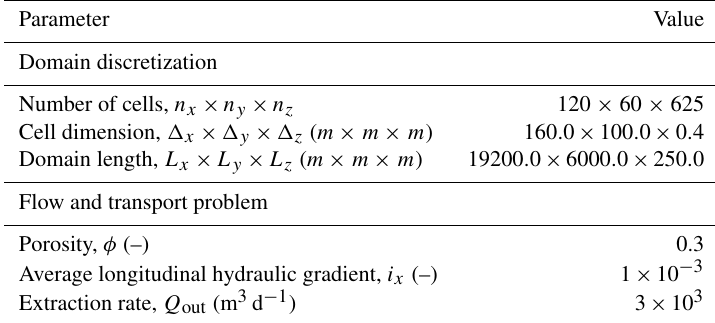
Table 6. Domain discretization and physical parameters used in all the simulations.